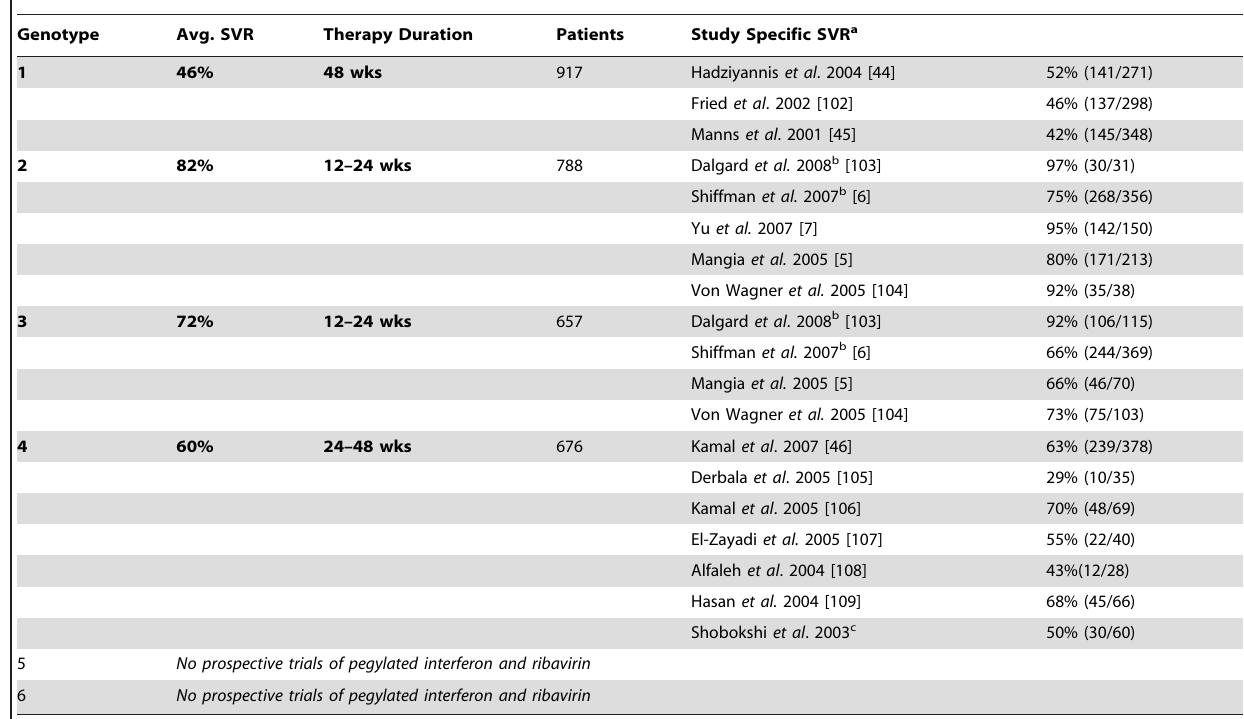
Table 2. Prospective HCV Trials of Therapy with Pegylated Interferon and Ribavirin.